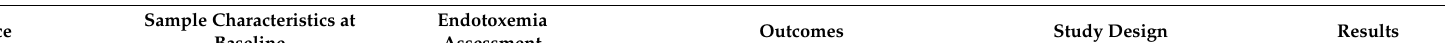
Table 1. Selective evidence on the association between a single high-fat meal and metabolic